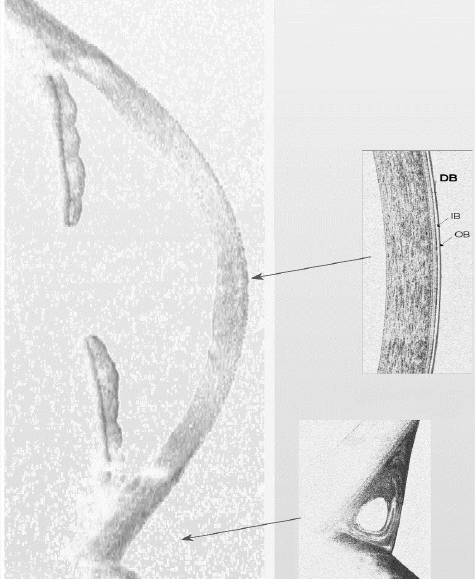
Figure 12. The integrative model of tear film behavior during the inter-blink period and visual fixation. In cross section, it is possible to detect, by optical coherence tomography (OCT), the behavior of the precorneal tear film (TF) as modification over time of the double-band (DB) structure. The latter consists of an inner (IB) and an outer (OB) layer of di ff erent reflectivity (small arrows). In addition, the high fluid dynamics of the tear meniscus evidenced by the presence of the vortex distribution pattern (after using a lipid-based tracer that enhances the reflectivity of tears) can also be seen. The continuous dynamism of the TF is the starting point of the model. Within the various areas of the ocular surface, the tear turnover should not be believed as a constant and single parameter since it has proved to be di ff erent, for instance, in the precorneal region (large arrow at the top) or in the menisci (large arrow at the bottom). Likewise, the various compounds (e.g., lipids, aqueous, or mucins) also revealed a di ff erent washout time. Intriguingly, as demonstrated by OCT imaging, there exists an inverse relationship between the tear clearance above the precorneal surface and that of the menisci, which may dynamically change (even reverse) as the environmental and bodily conditions evolve (e.g., dry eyes exhibit “opposite” behavior with respect to healthy eyes). Moreover, although the precorneal TF in healthy subjects shows an absent or very low clearance during visual fixation, it finely vibrates due to small eye movements, thus supporting a non-quiescent model of human